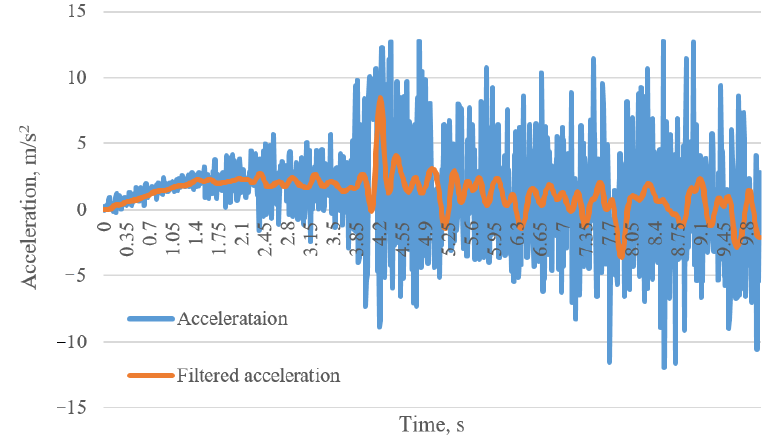
Figure 5. First test acceleration results with and without the filter.